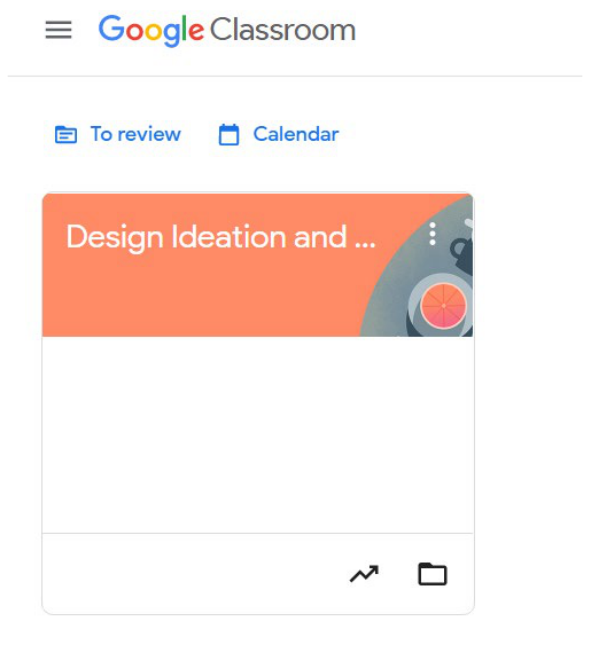
Figure 1. Google Classroom introductory page.